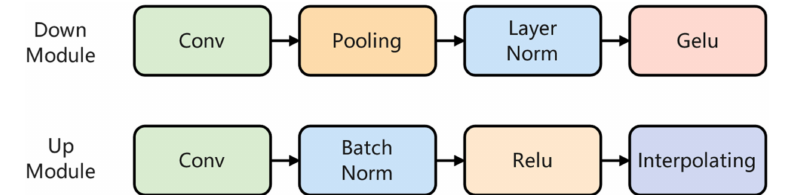
Figure 8. Double-Branch fusion